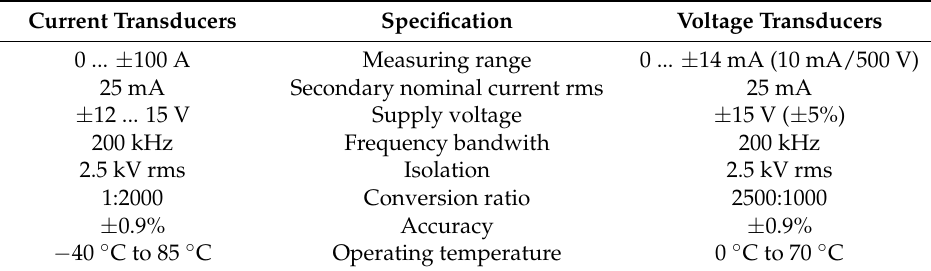
Table 3. Characteristics of AC and DC voltage and current sensors.